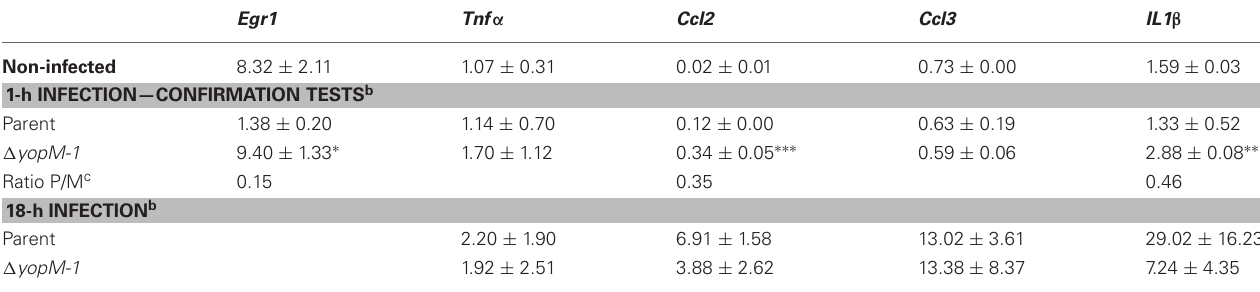
Table 8 | Relative transcript levels a for a set of inflammation-related genes in splenic CD11b + cells from infected